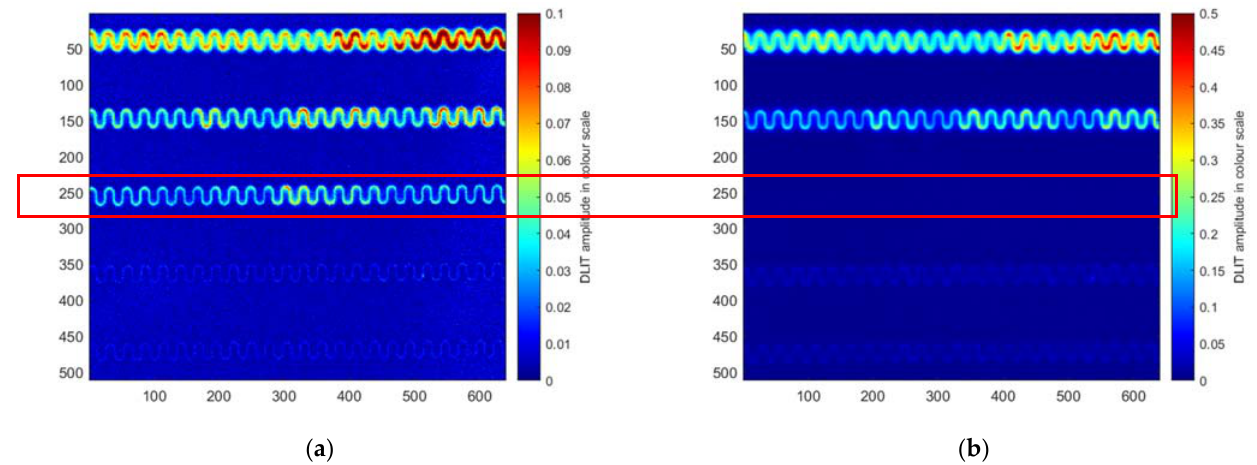
Figure 7. DLIT amplitude images of Test Sample 1 ( a ) without complete wire break; ( b ) with a complete wire broken on the third wire.